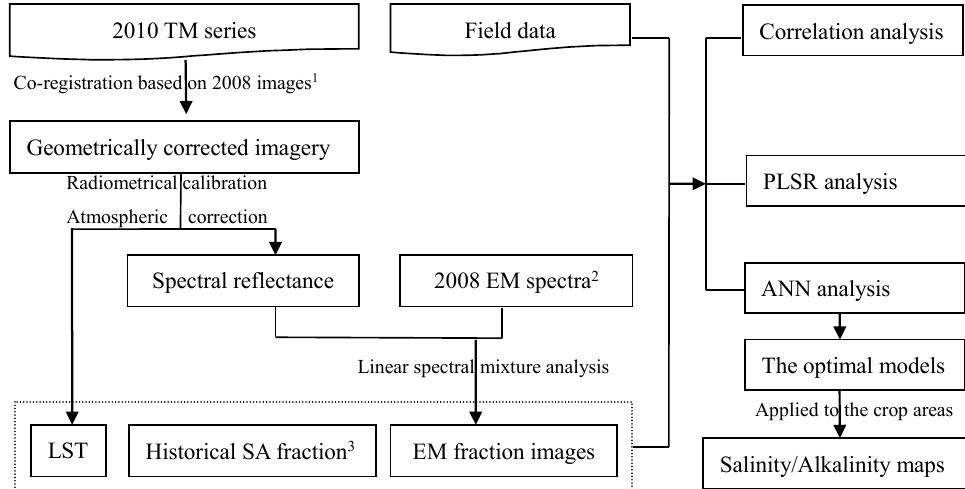
Figure 2. Flowchart of methods used in the study. 1 The 2008 images are geometrically rectified in Reference [21]; 2,3 The 2008 EM spectra and historical SA fraction are derived from 2008 images in Reference [21]. ANN: artificial neural network; EM: spectral endmember; LST: land surface temperature; PLSR: partial least squares regression; SA: saline land.